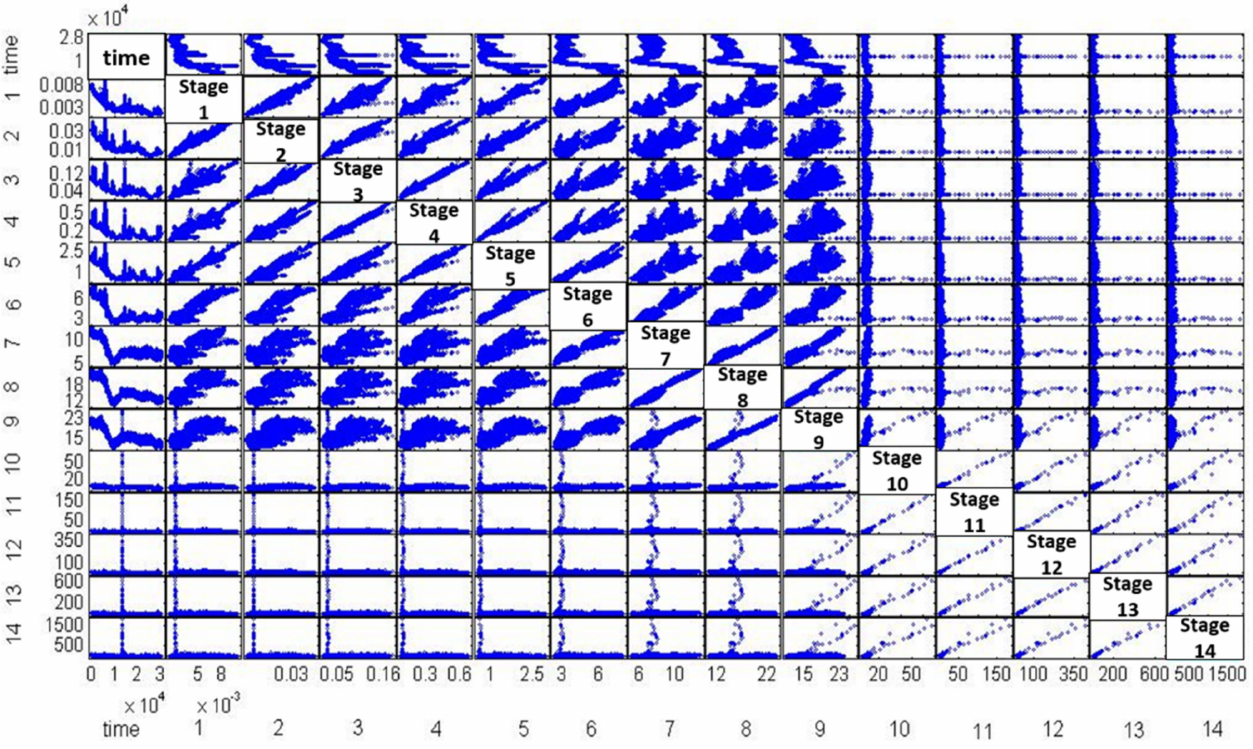
Figure 4. Linear correlation plots of PM concentrations (expressed in µ g/m 3 ) among all the ELPI+ fraction daily patterns derived from data monitored in the garage on 27 March 2018. Time as well as PM values associated with the ELPI+ stages (1–14) are reported on the x and y